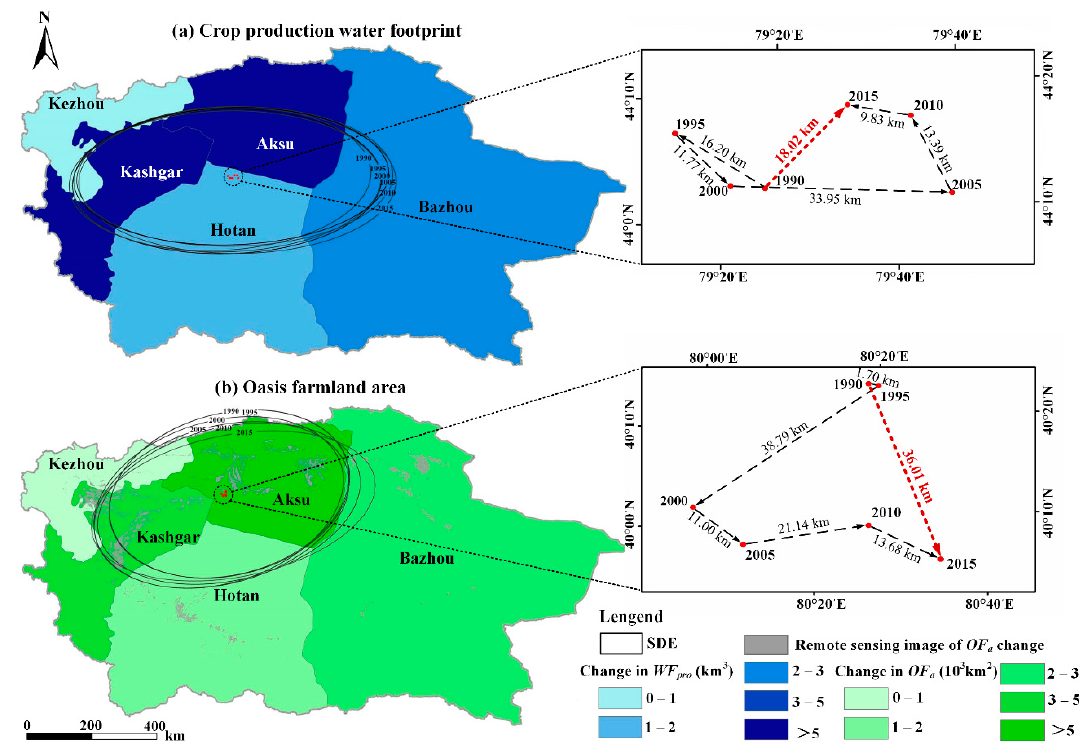
Figure 3. Change and migration trajectories of crop production water footprint (WF pro ) and oasis farmland area ( OF a ) in TRB during 1990 to 2015 .